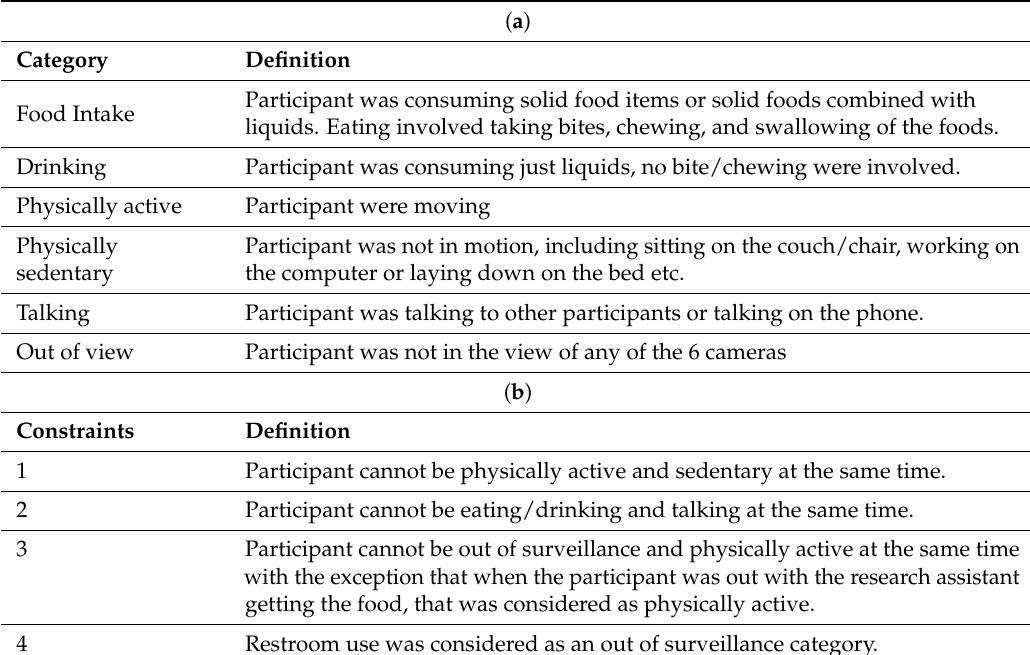
Figure 2. A snapshot of the software used for video observation and annotation. The annotator can view all six cameras simultaneously and can mark start and end of different activities. Table 1. ( a ) Definitions of categories for activity annotation; ( b ) Constraints placed on activity annotation.